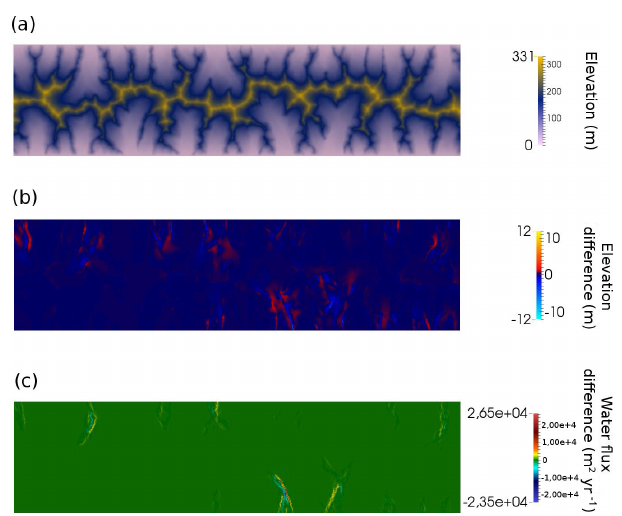
Figure 7. Final steady state of an example model run for the node- to-node MFD algorithm. (a) Final model elevation where the do- main is 800km long by 100km wide and uplift is fixed at U = 10 − 4 myr − 1 , the linear diffusion coefficient is κ = 1m 2 yr − 1 , the fluvial diffusion coefficient is c = 10 − 4 (m 2 yr − 1 ) n − 1 , and the wa- ter flux exponent is n = 1 . 5. (b) Difference in elevation between the last two model time steps, where the time step duration is 100 years. (c) Difference in water flux between the last two model time steps.